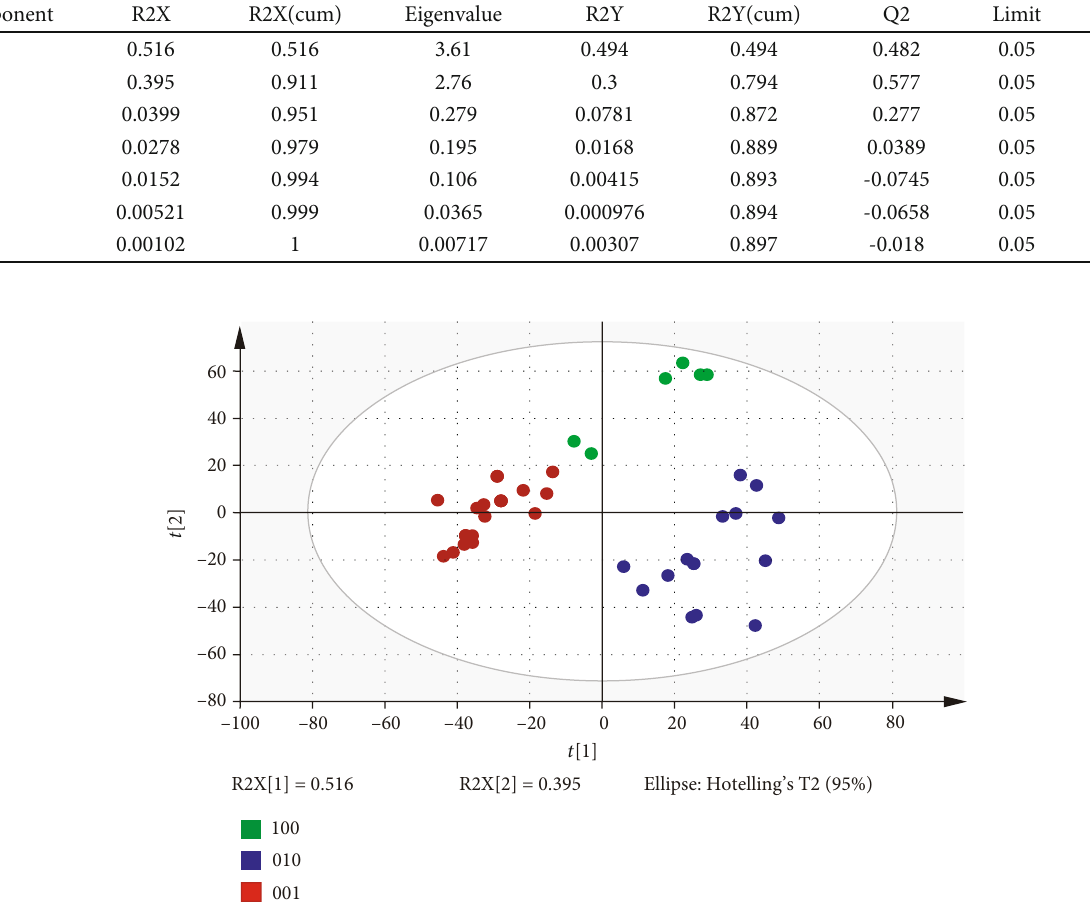
Table 3: Relevant statistical results of modeling with di ff erent principal component numbers.